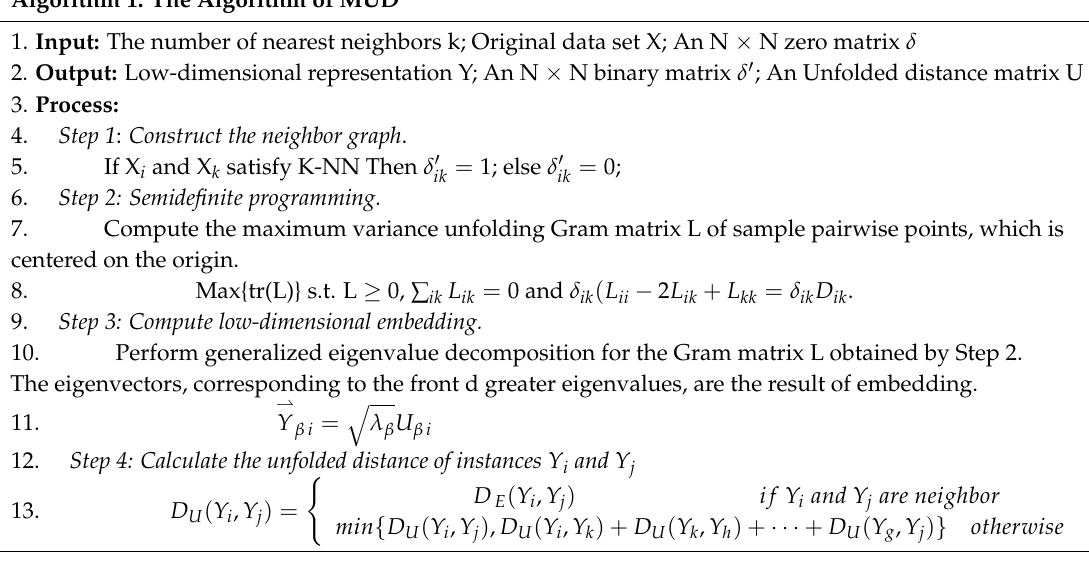
Algorithm 1. The Algorithm of